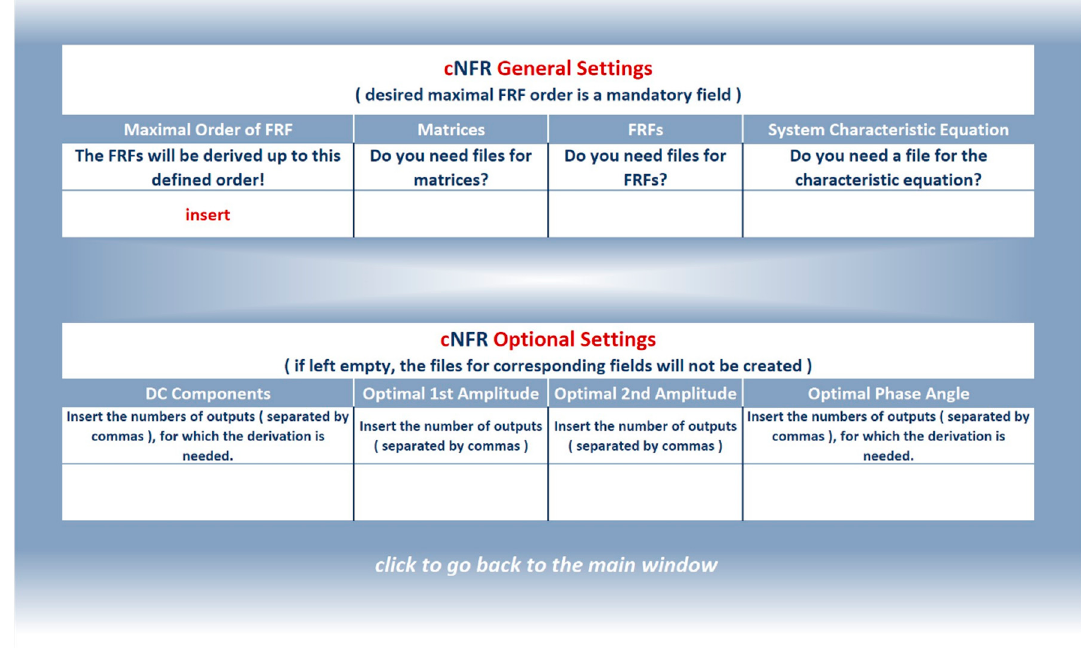
Figure 5. The cNFR Settings Window.